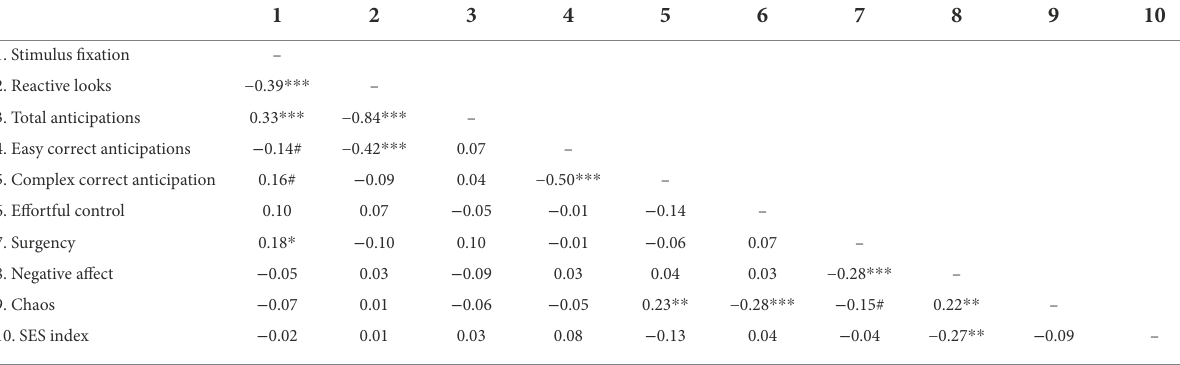
TABLE 3 Two-tailed partial correlation coefficients, controlling by age, for attentional scores and child’s temperament and environmental factors in the first